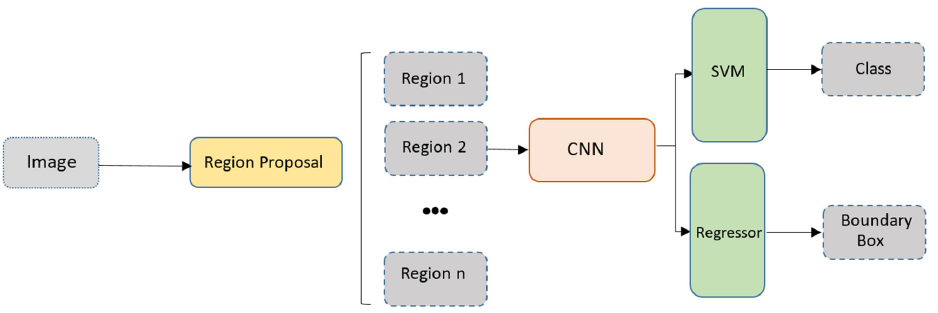
Figure 10. The architecture of the region-based CNN (R-CNN) algorithm.